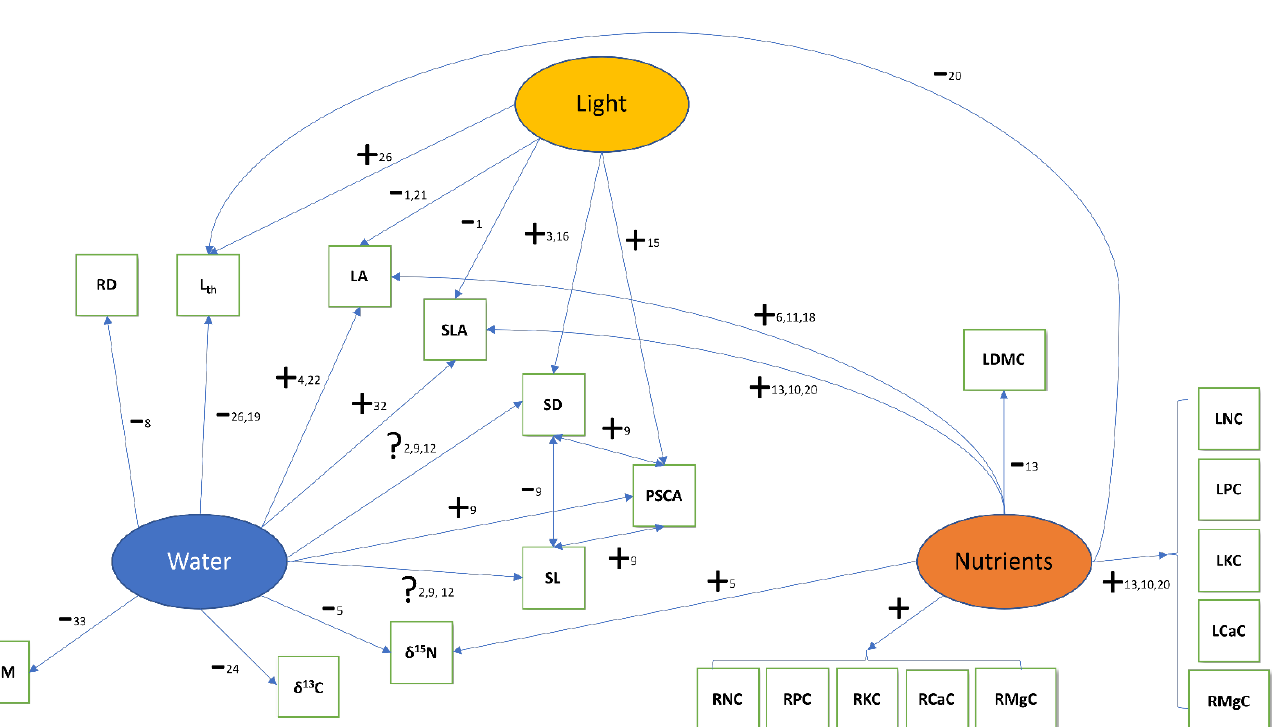
Figure 1. Expectations regarding the direction of the trait-environment relationships for epiphytes along (micro-) environmental gradients of water, nutrient, and light availability at the local scale. “+”: positive relationship, “−”: negative relationship, “?”: direction of relationship unclear. Trait abbreviations are explained in Table 1. Numbers refer to publications that established these links and which are listed in the supplement. For a full list of traits, see Table 1.